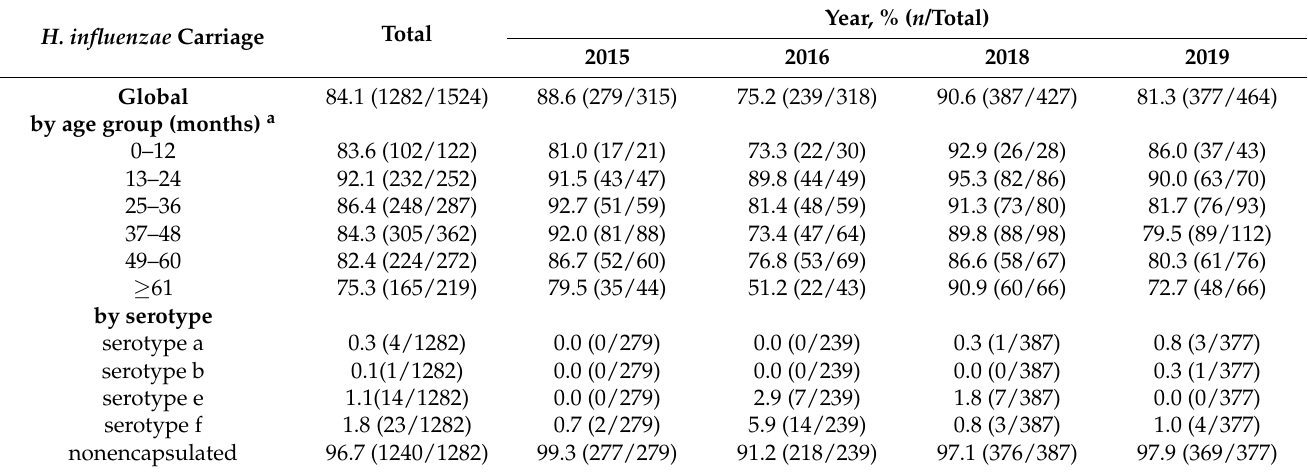
Table 2. Colonization rates and capsular types.